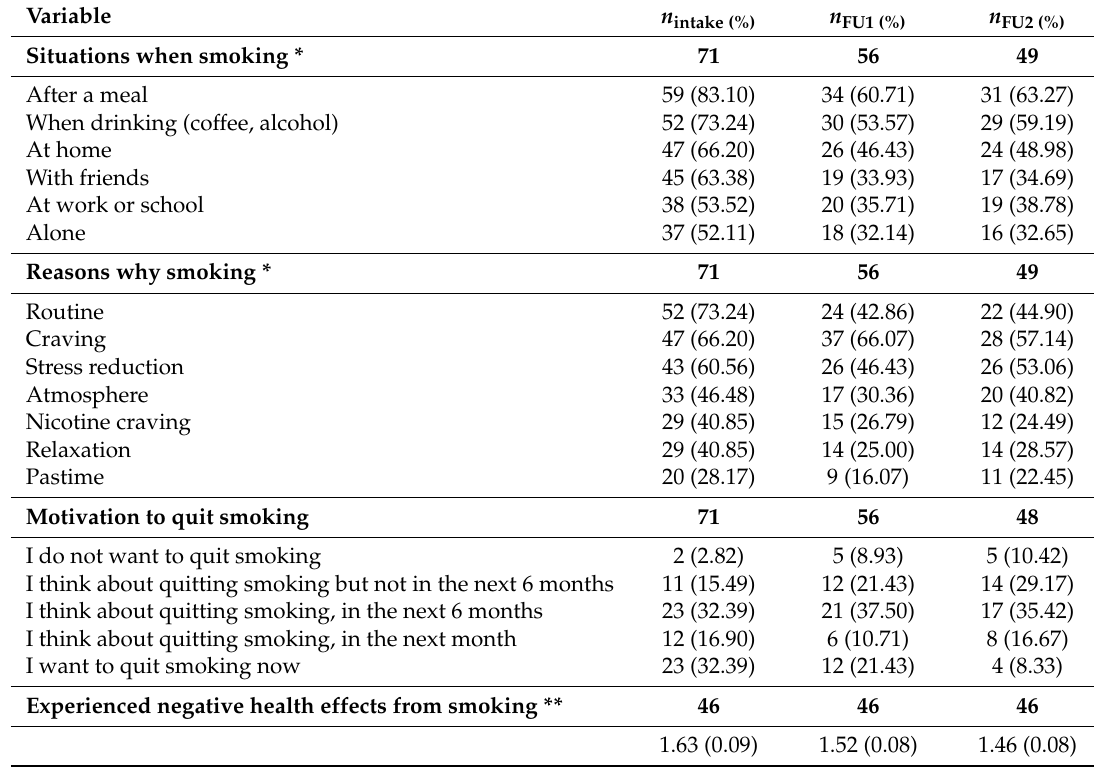
Table 2. Smoking profile: situations when smoking, reasons why smoking, motivation to quit